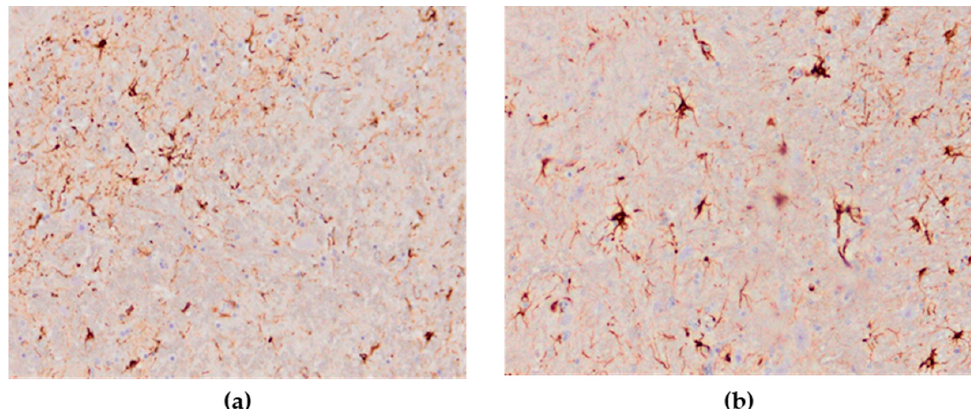
Figure 11. Numerous GFAP-positive astrocytes in the brain of HPAI H5N8 positive chickens (original magnification (a) × 100, (b) × 400).